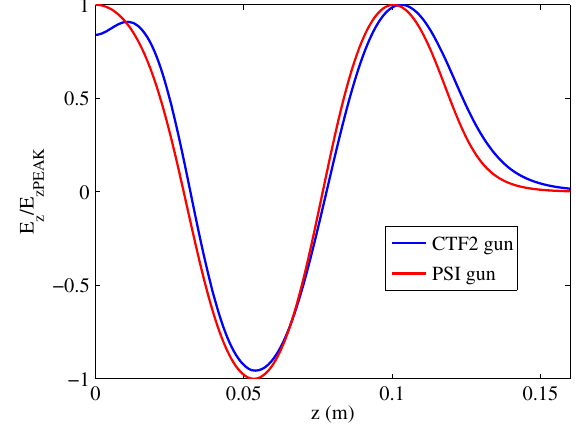
FIG. 4. CTF2 and PSI gun electric field along the gun longitudinal axis z normalized to the peak value along the same axis.